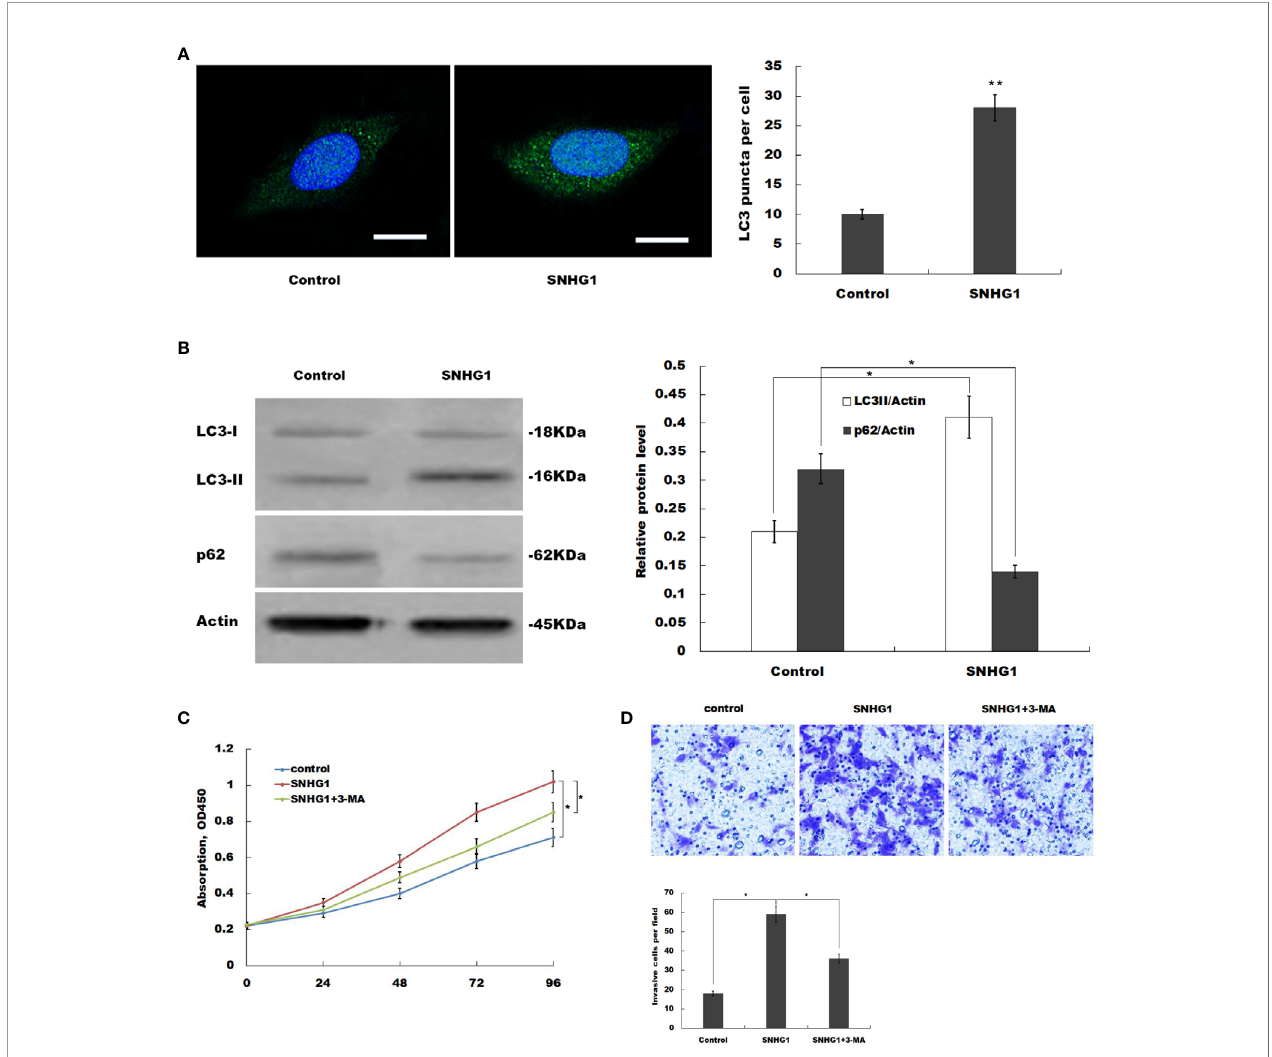
FIGURE 3 | SNHG1 promotes bladder cancer cell autophagy. (A) T24 cell was cultured with overexpressed SNHG1 or control, a Cyto-ID autophagy detection kit was used to evaluate cell autophagy. (B) T24 cells were cultured with overexpressed SNHG1 or control; western-blot was used to determine the protein expression levels of LC3I, LC3II, and p62. (C) T24 cells were cultured with overexpressed SNHG1 , overexpressed SNHG1 plus 5mM 3-MA, and control, MTT assay was used to evaluate the number of viable cells levels. (D) T24 cells were cultured with overexpressed SNHG1 , overexpressed SNHG1 plus 5mM 3-MA, and a control, cell invasion assay was used to determine cell invasion(Data presented as mean ± SD, *p < 0.05, **p < 0.01 compared to the